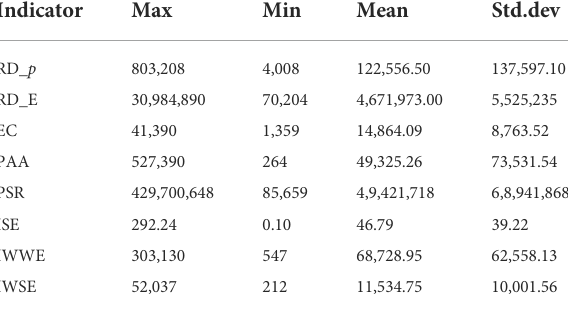
TABLE 3 Descriptive statistics of the ef fi ciency evaluation